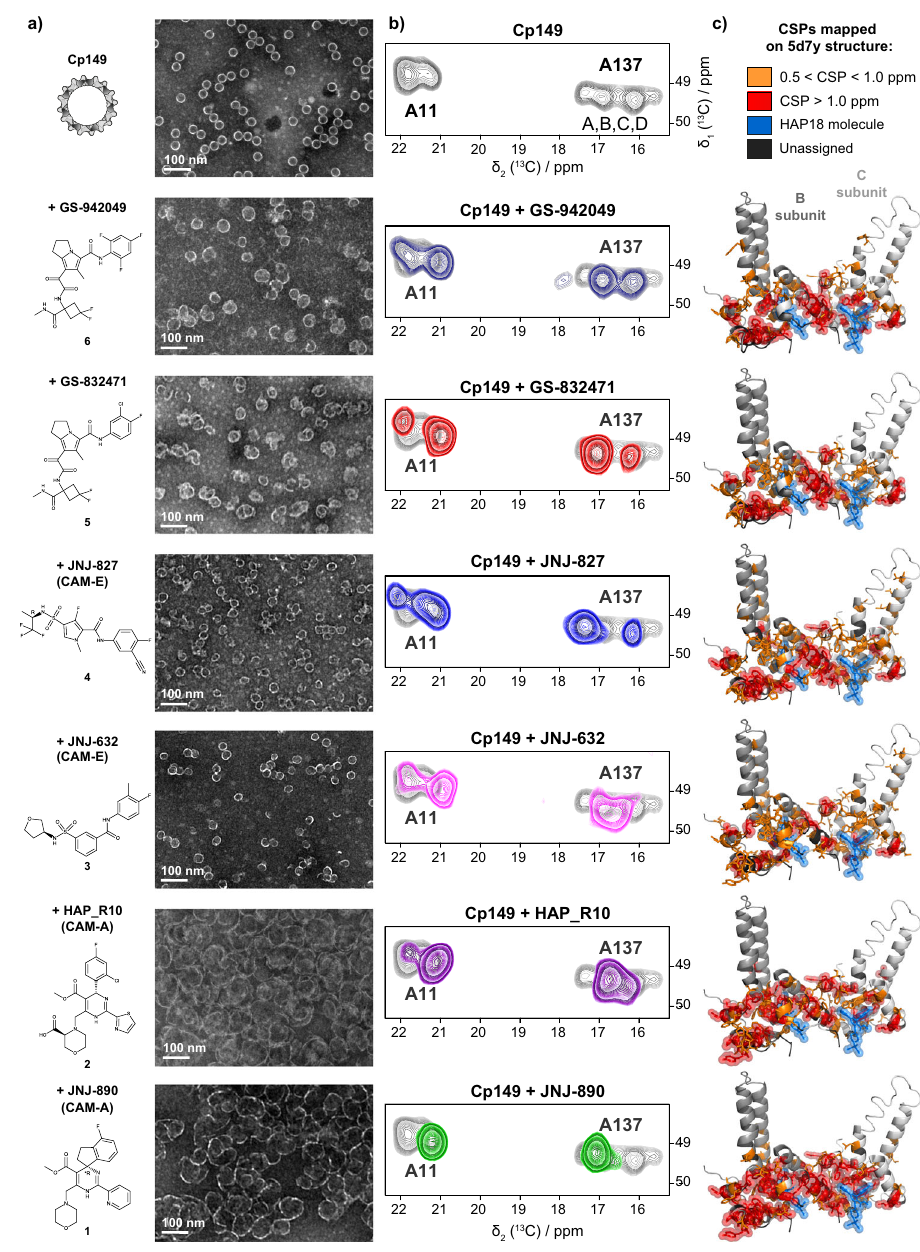
Fig. 2 | CSPs induced by different CAM-A and CAM-E compounds. a Negative- staining EM micrographs corresponding to the 13 C- 15 N Cp149 reassembled capsids in absence (for reference) or presence of CAM, with their chemical structure. The EMpictures weretakenonsinglelabeledsamples, and experiments were repeated independently at least once on unlabeled samples and yielded similar results. b Extracts from the NMR DARR spectra showing the A11 and A137 alanine C α -C β region for all tested compounds. In light gray is the control spectrum for